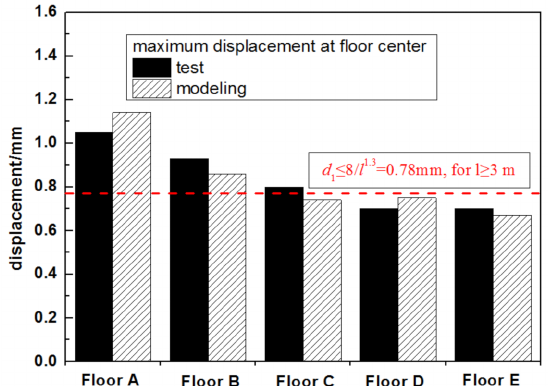
Figure 16. Experimental and modeled maximum displacement at floor center.